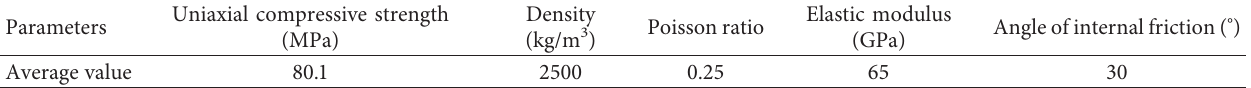
Table 1: Limestone mechanical parameters.